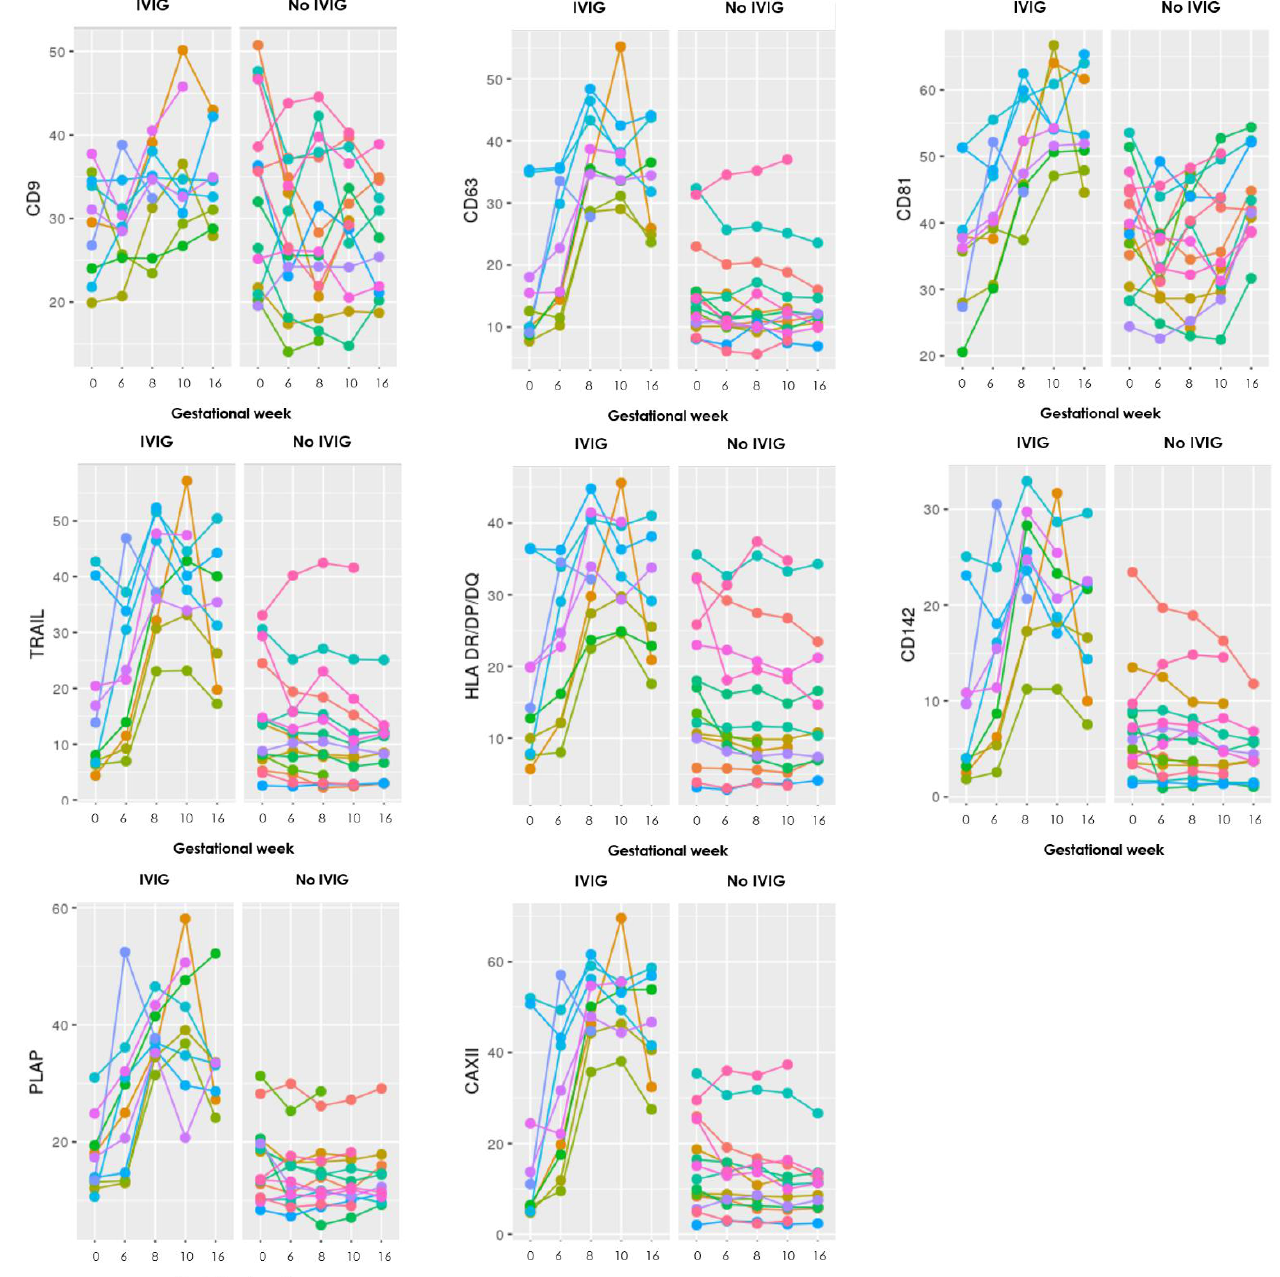
Figure 2. Graphs showing the progression during pregnancy of eight EV markers examined with the EV array in the LB group, where each color represents an individual person. To the left are those who received IVIG treatment and to the right those who did not. Gestational week is depicted on the x-axis and absolute levels of the marker along the y-axis (the remaining nine markers can be seen in Appendix B).